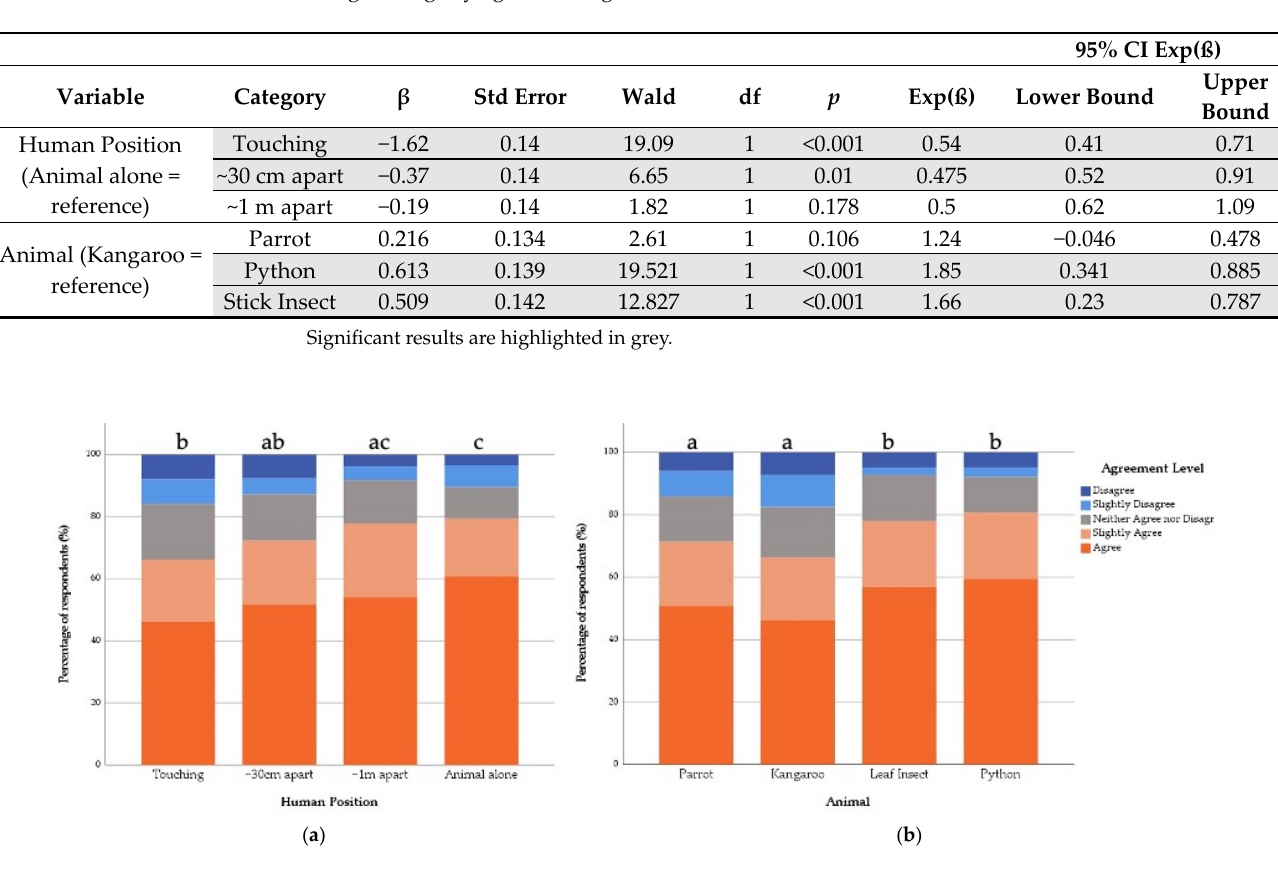
Figure 5. Percentage of General Public respondents’ agreement with the statement “the featured animal is displaying a natural behaviour” in relation to the ( a ) Human Position shown and ( b ) Featured Animal shown. Same letters indicate no statistical difference and different letters indicate statistical differences between variables in the fitted model.